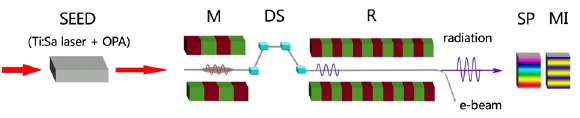
FIG. 1. Schematic of the SDUV-FEL (SEED is the external laser seed, which consists of a Ti:Sa laser system followed by an OPA, M is the variable-gap modulator section, DS is the dispersive section, R is the variable-gap radiator section, SP is the spectrograph, and MI is the Michelson